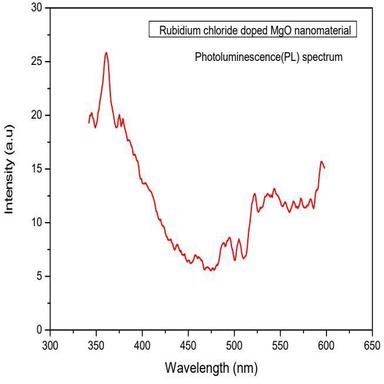
PL spectrum of RbCl doped MgO nanomatrial.